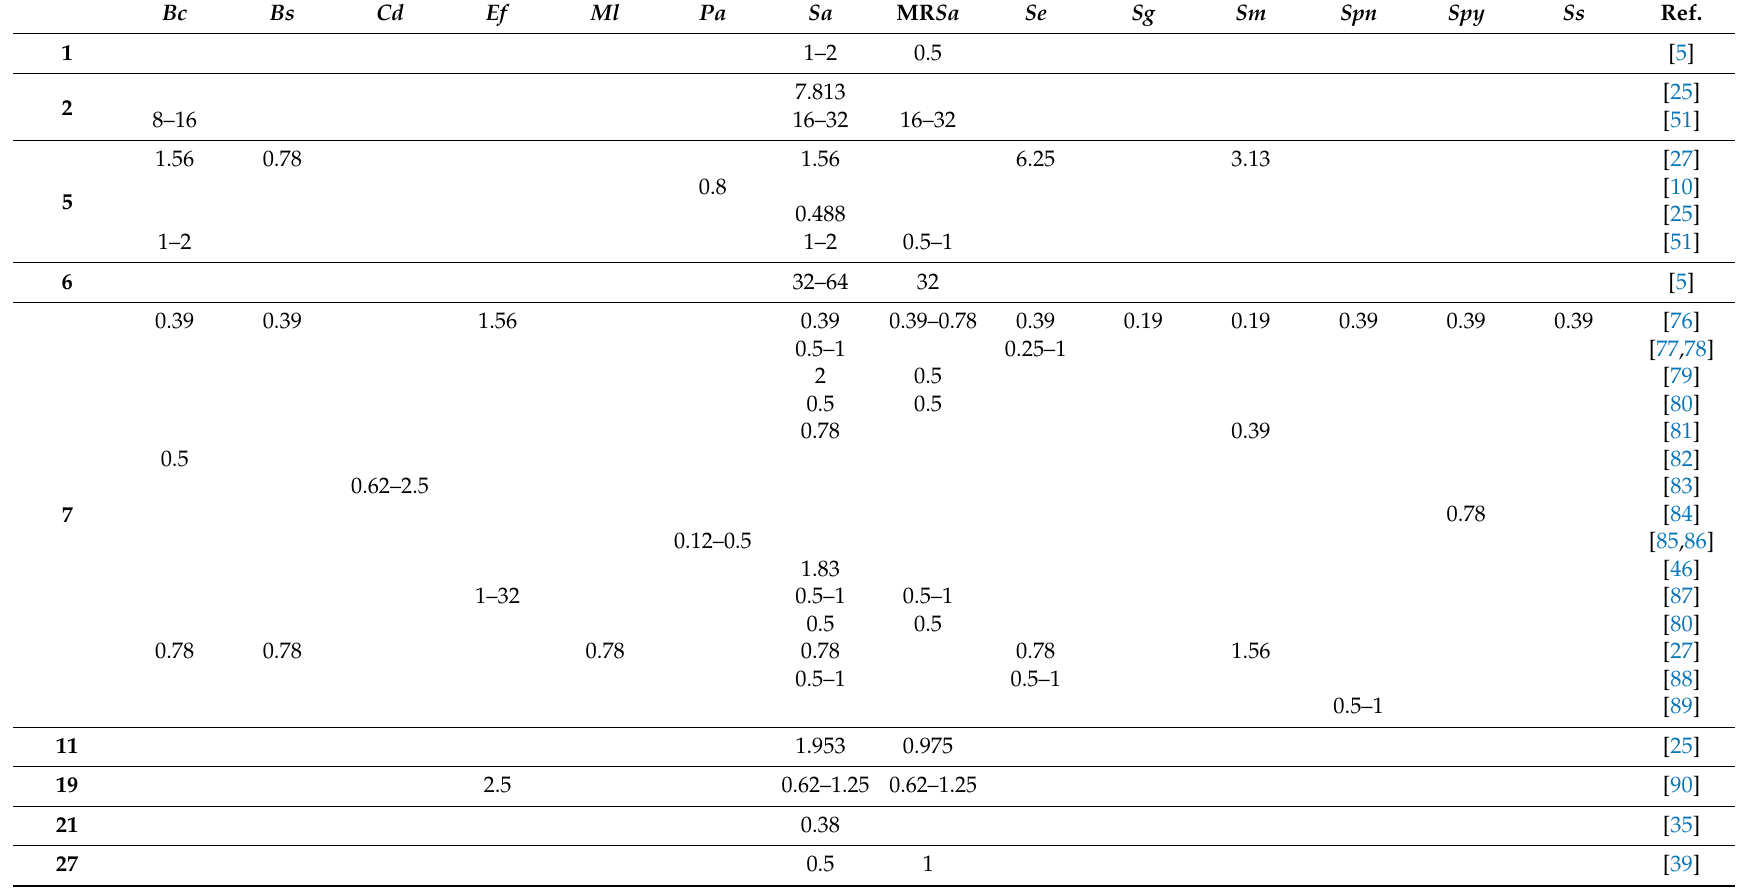
Table 3. Bioactivity of myrtucommulones and related compounds resulting from assays carried out on Gram-positive